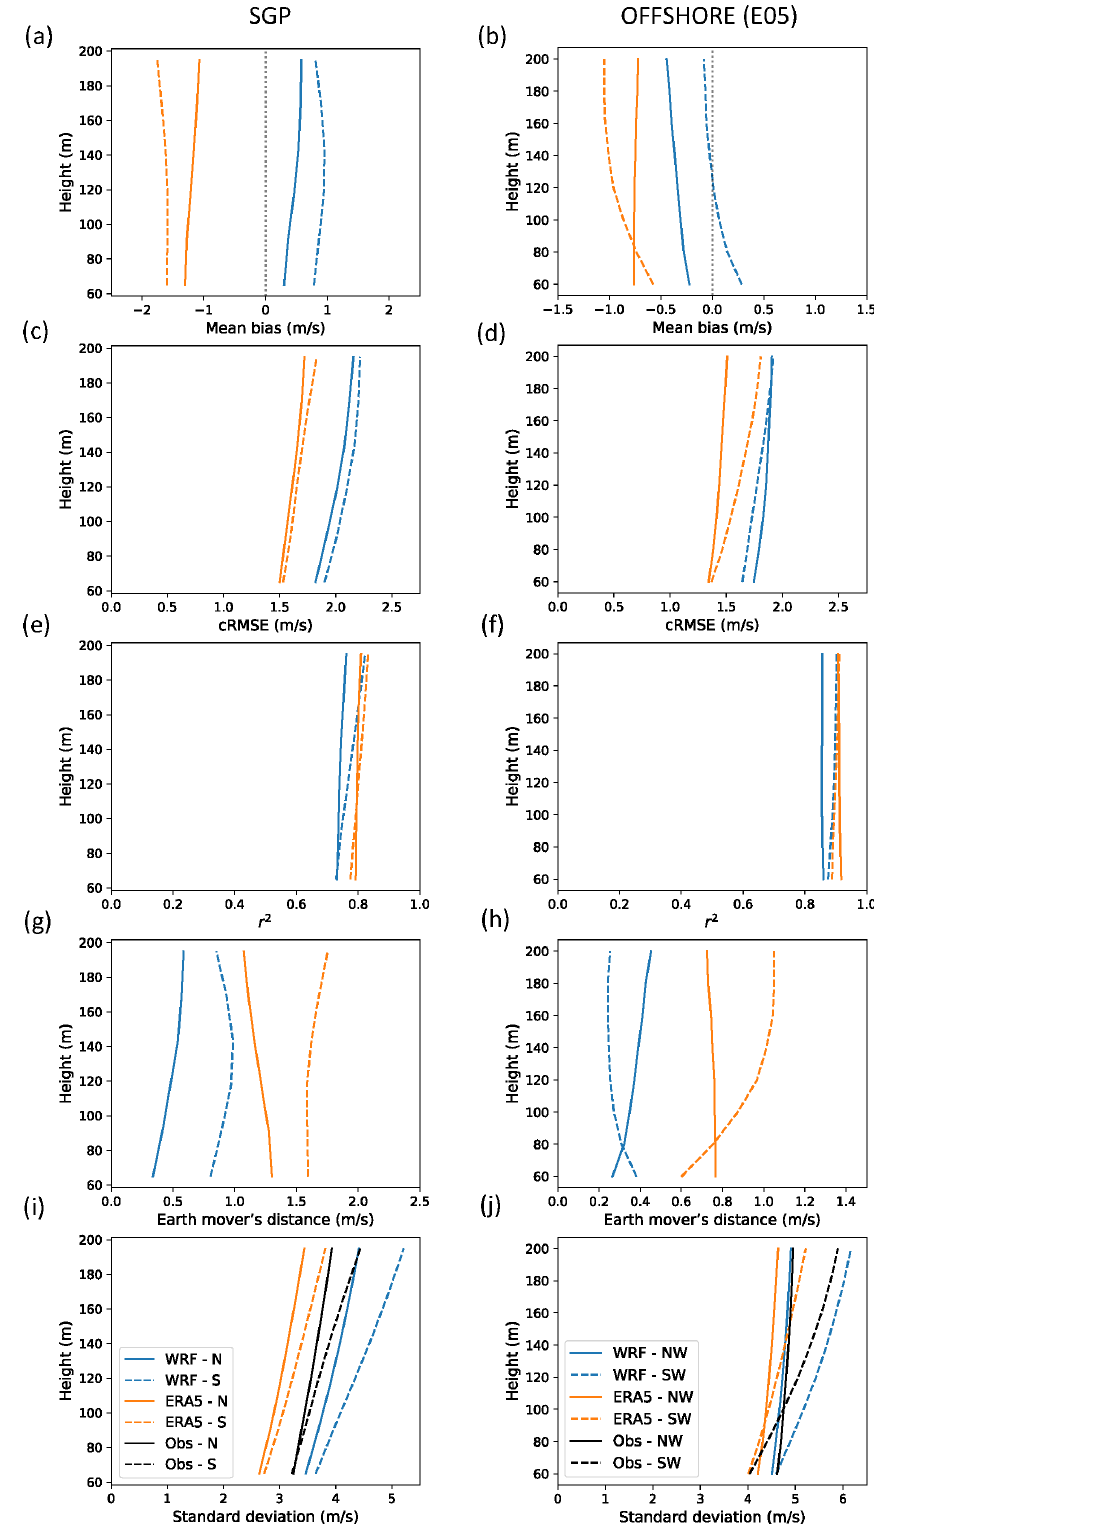
Figure 7. Vertical profiles of performance metrics segregated by dominant wind direction regimes at the SGP C1 site (left) and at the location of the E05 lidar (right). Results from the E06 lidar are included in the